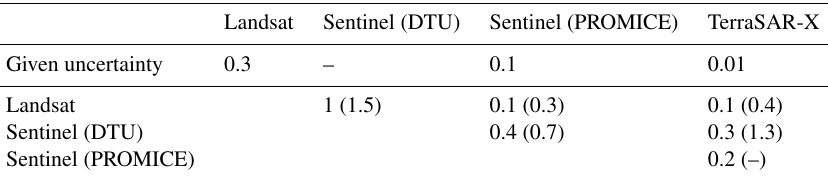
Table A1. First row: uncertainties specified for each data set. Rows 2–4: root-mean-square (RMS) differences between the two data sets indicated in the line and column heads, evaluated within the ablation area of Harald Moltke Bræ. As the temporal variability of the flow velocities within 1 month is not negligible, we distinguish between months with slow maximum velocities ( < 2md − 1 ) and high maximum velocities ( > 5md − 1 , parentheses). Unit is md − 1 .